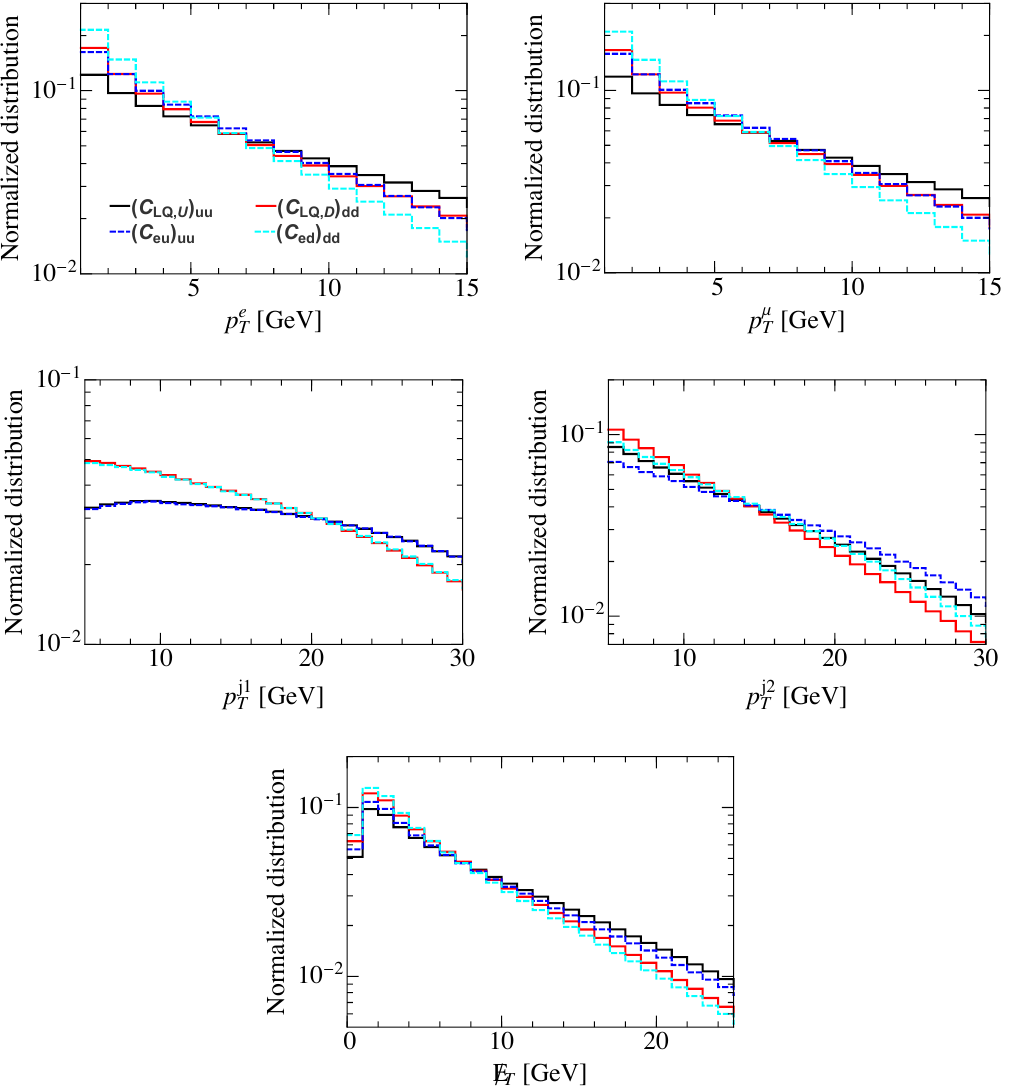
Figure 5 . Electron, muon, leading and subleading jet p T distributions and missing energy distribu- tion induced by four-fermion operators with different τ polarization at the EIC, with E √ and E = 250 GeV ( S = 141 p